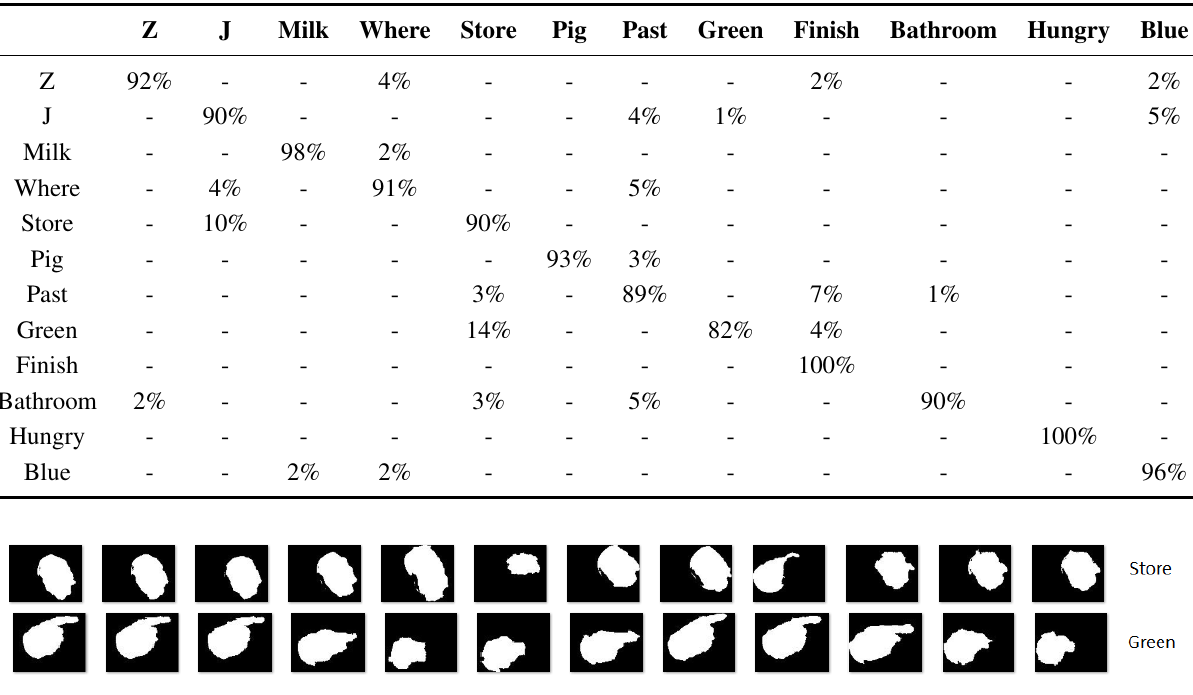
Figure 6. Examples of sequences of the gestures store and